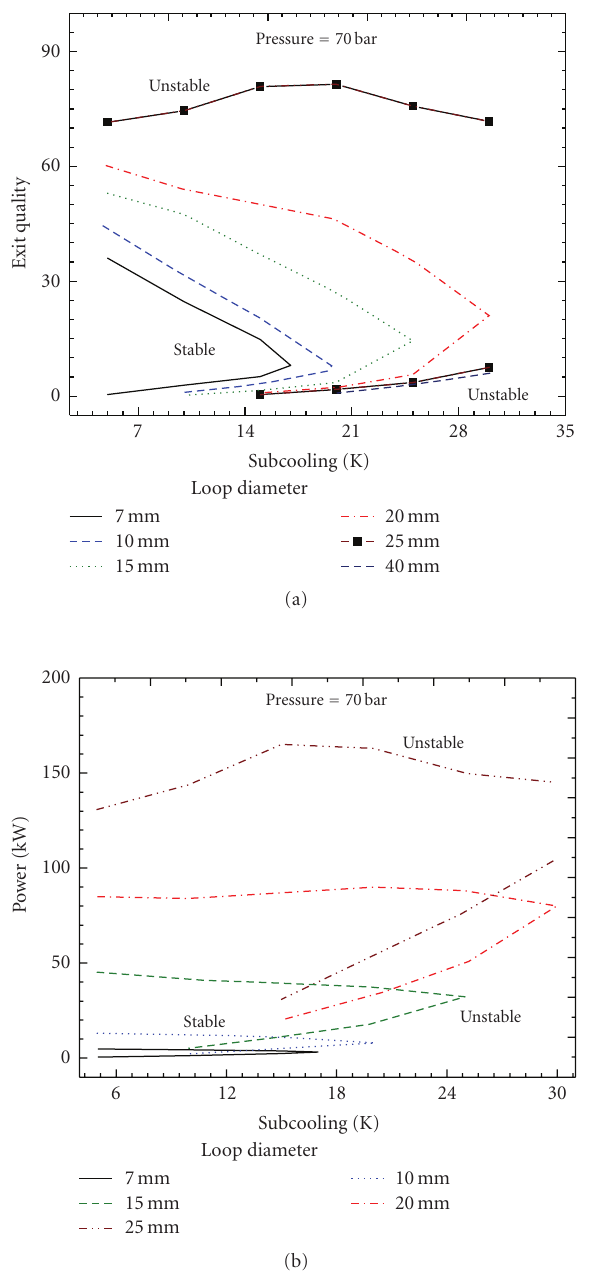
Figure 21: Predicted stability map for various loop diameters. specified for ensuring stability for all anticipated operations like start-up, power raising, and step back. One would expect the decay ratio to go through a minimum while moving from the lower to the upper threshold for a fixed subcooling (Figure 24). Ideally, the operating line shall pass through the minimum decay ratio line (locus of all minimum decay ratio points (see also Figure 24)) so that all oscillations will die down in the quickest possible manner. In stability- controlled designs, one could choose the operating line as the minimum decay ratio line if found feasible from feed water inlet temperature considerations (see also Vijayan et al. [40]).